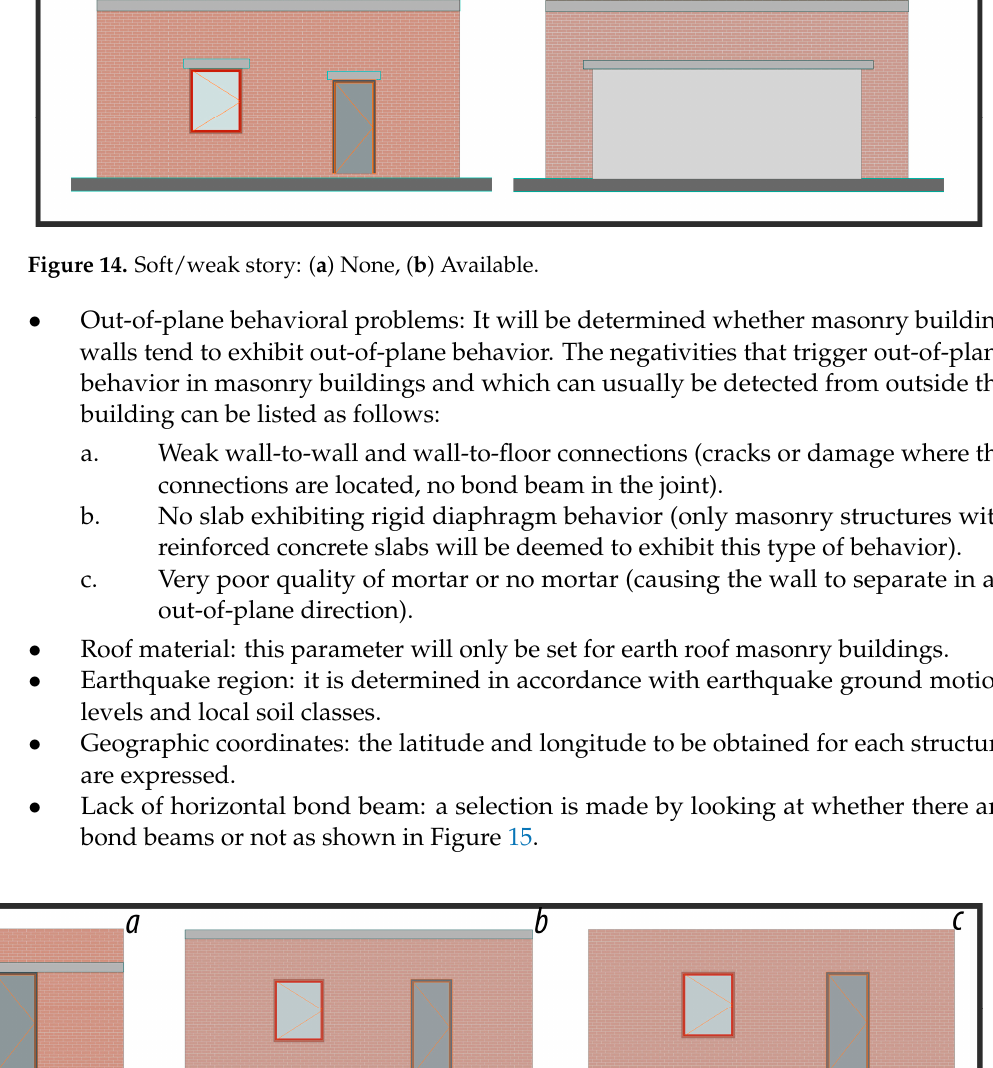
Table 8. Negative parameter values (𝑂 (cid:3036) ) [16].